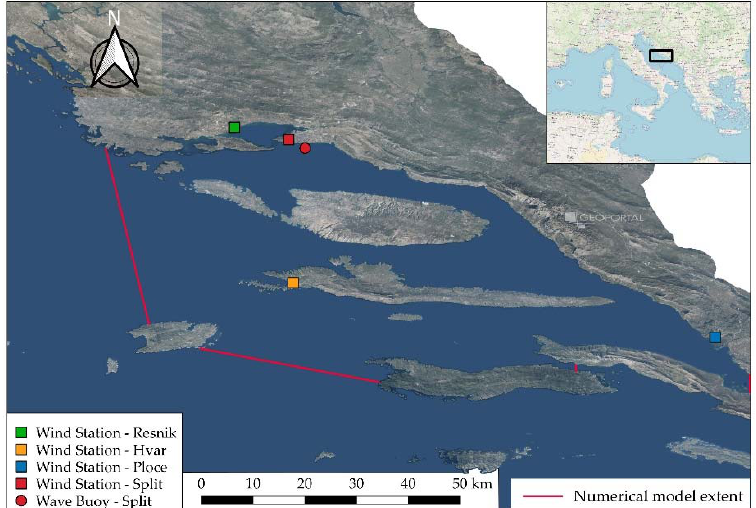
Figure 1. Map of the study site on southern Croatian coast (mid-latitude Adriatic), showing four wind stations (rectangles) and one wave station (circle), which are described in detail in Section 2.3; the map is shown in the EPSG: 4326—WGS 84 coordinate reference system.